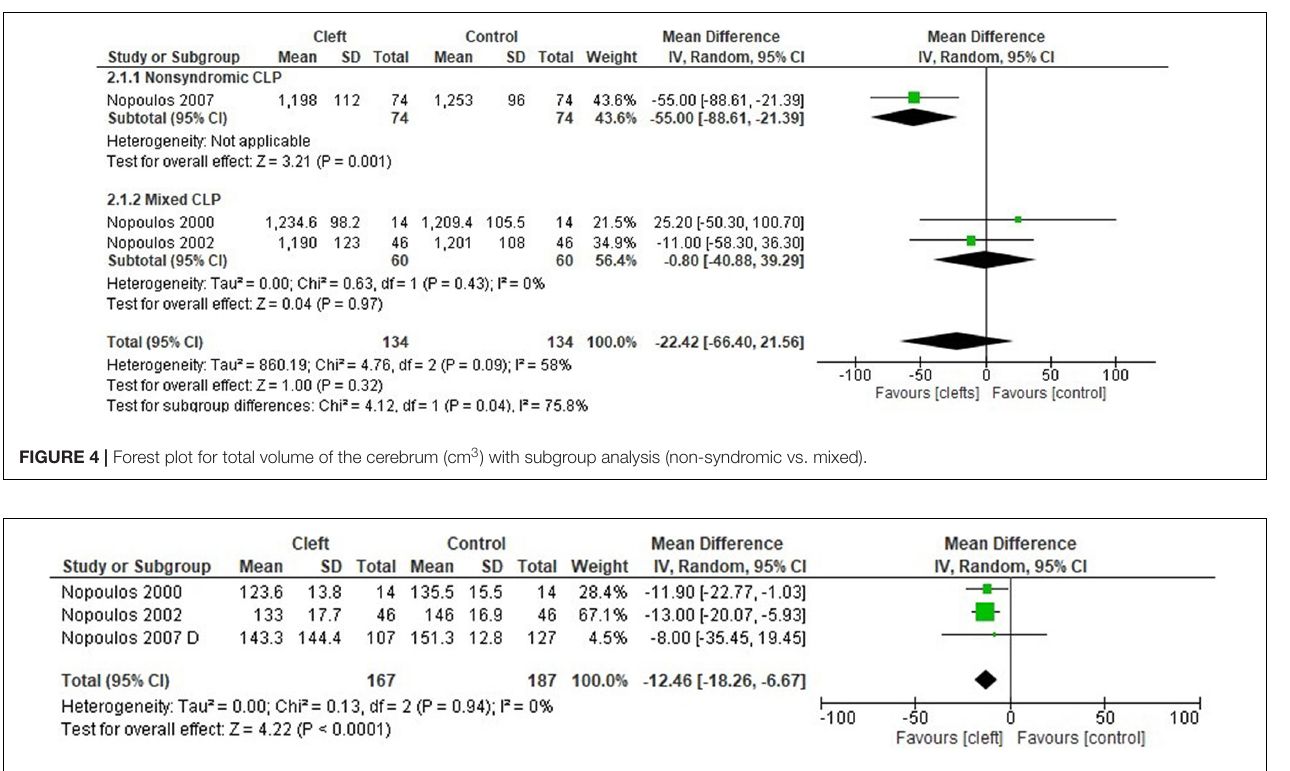
FIGURE 5 | Forest plot for total volume of the cerebellum (cm 3